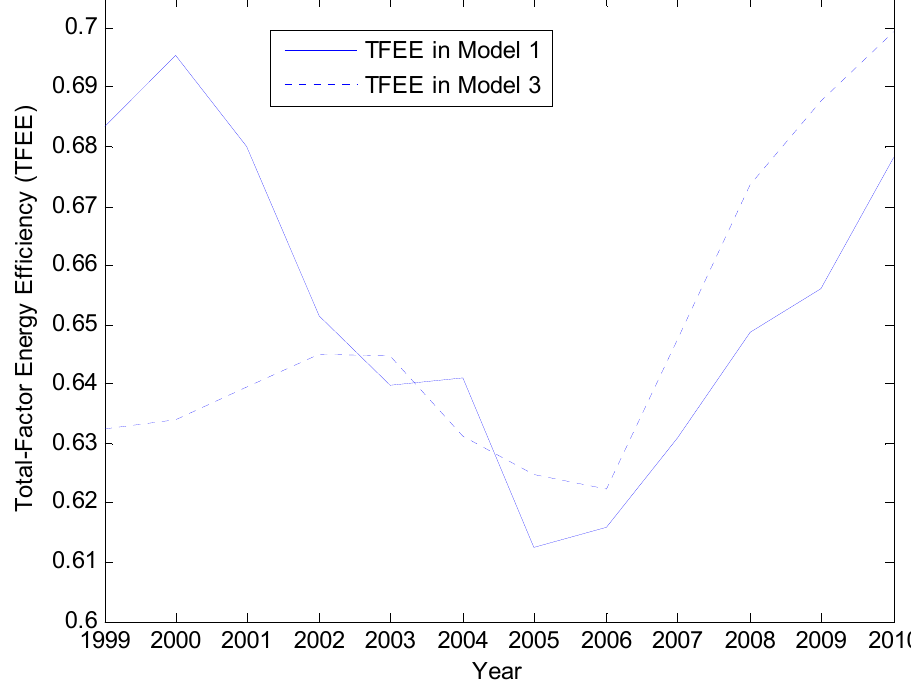
Figure 6. TFEE estimated by Model 1 (with land factor) and Model 3 (without land factor).